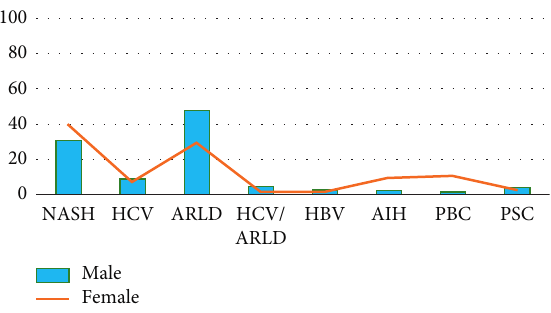
Figure 1: Common indications for the liver transplantation waiting list in the United States without HCC by gender in 2019 [9]. AIH: autoimmune hepatitis; ARLD: alcohol-related liver disease; HBV: hepatitis B virus; HCC: hepatocellular carcinoma; HCV: hepatitis C virus; NASH: nonalcoholic steatohepatitis; PBC: primary biliary cholangitis; PSC: primary sclerosing cholangitis. Table 1: Commonly followed selection criteria for alcoholic hepatitis patients for liver transplantation. Inclusion for liver transplantation